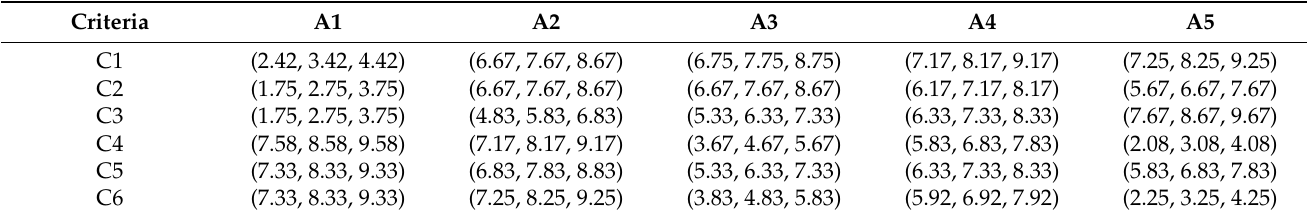
Table 7. The fuzzy synthetic performance rating matrix.